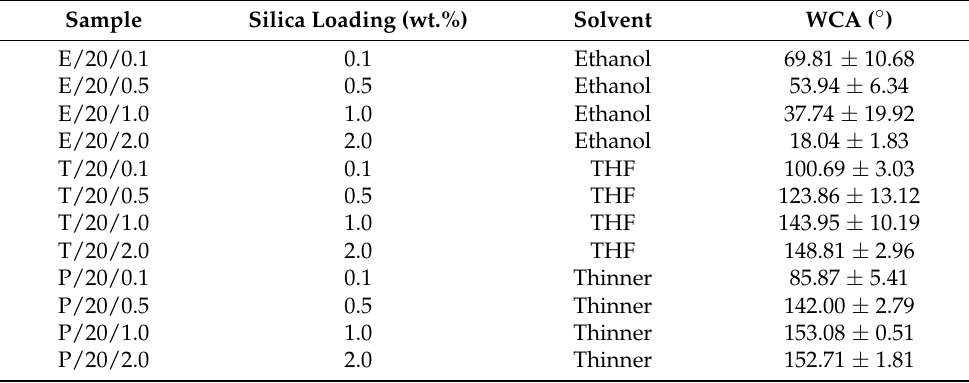
Table 2. WCA of PU coating with varied loadings of silica nanoparticles in ethanol, THF, or thinner prepared using dual-layer coating using different types of solvent for the second layer of